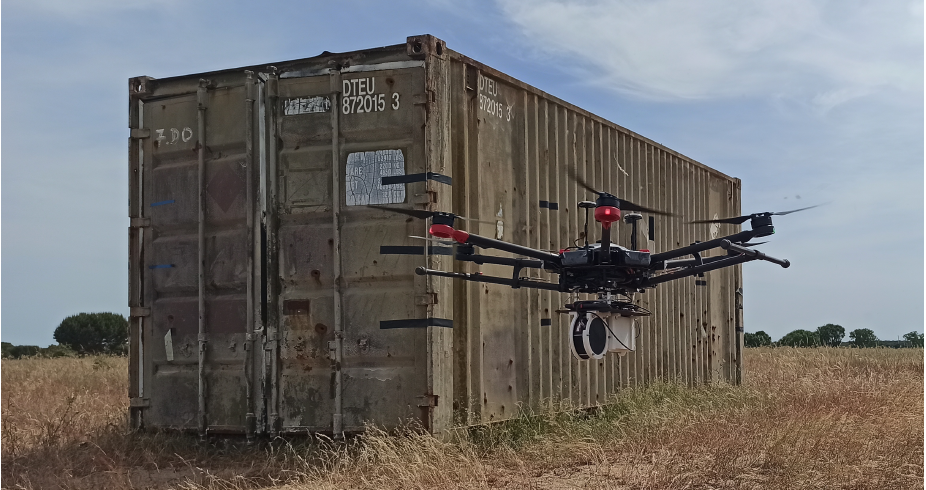
Figure 11. Multirotor with developed radiation detection system screening a shipping container cargo.